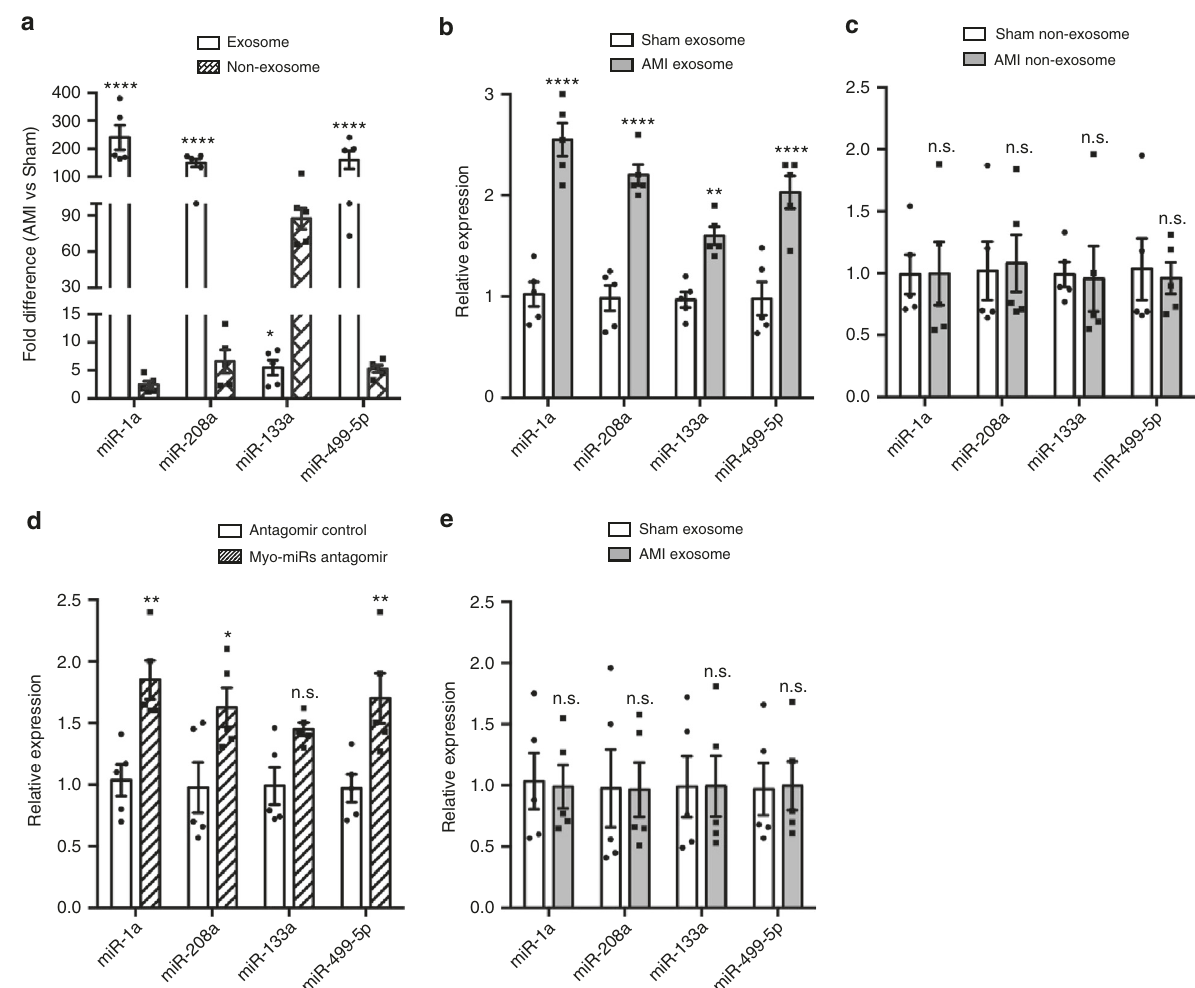
Fig. 2 Exosomes mediate the transfer of circulating myo-miRs into BM-MNCs. Exosomes and the non-exosomal component were isolated from the plasma of AMI and Sham mice 6 h post-surgery. a The levels of myo-miRs in the exosomes and the non-exosomal component were analyzed by qRT-PCR and expressed as fold difference in AMI vs. Sham mice. * p < 0.05, **** p < 0.0001 vs. Sham. n = 5 animals per group. b , c In vitro, freshly-isolated mouse BM- MNCs (2 × 10 7 /well) were treated for 12 h with the exosomes (20 μ g) ( b ) or non-exosomal component (150 μ l) ( c ) from AMI or Sham mice; then, the levels of myo-miRs in the BM-MNCs were quanti fi ed with qRT-PCR. ** p < 0.01, **** p < 0.0001 vs. treatment with Sham exosomes or Sham non-exosomal component; n.s. not signi fi cant. n = 5 biologically independent samples per group. d , e In vivo, exosomes (40 μ g in 300 μ L PBS/mouse) ( d ) or the non- exosomal component (300ul/mouse) ( e ) from AMI or Sham mice was i.v . injected into intact C57BL/6 mice; 12 h later, the levels of myo-miRs in